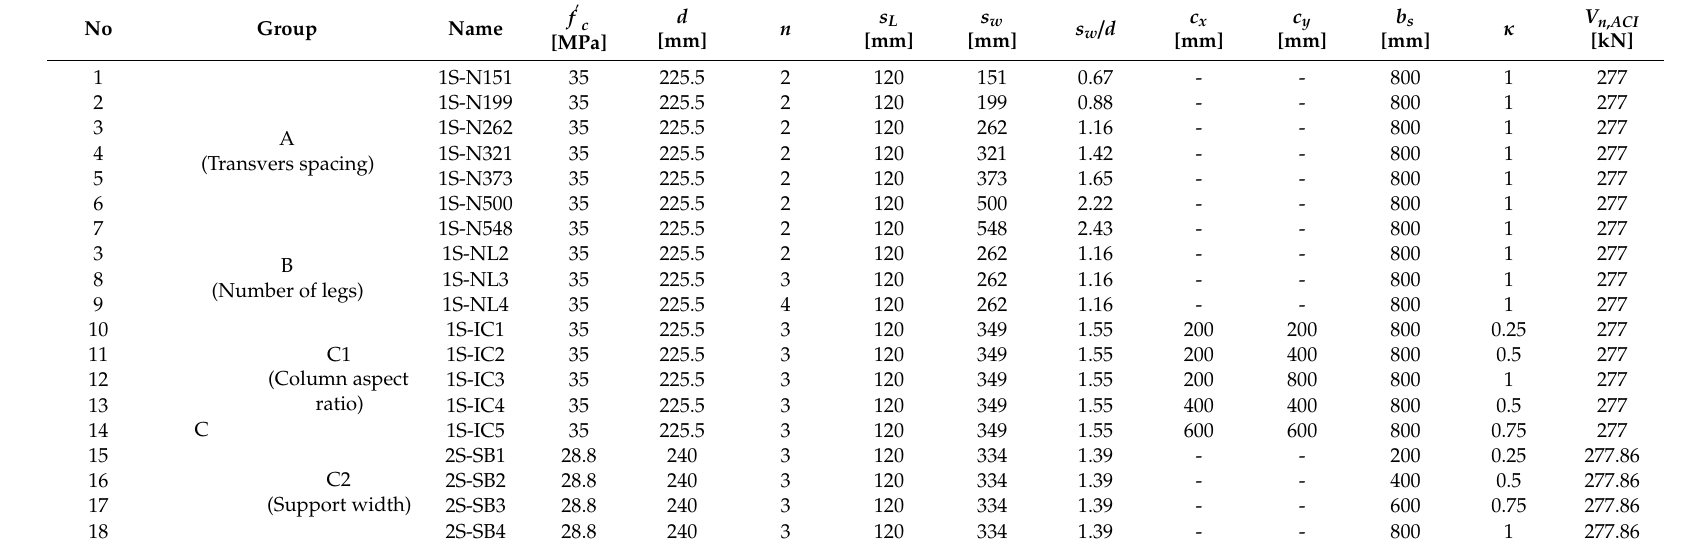
Table 2. Grouping and details of the experiment